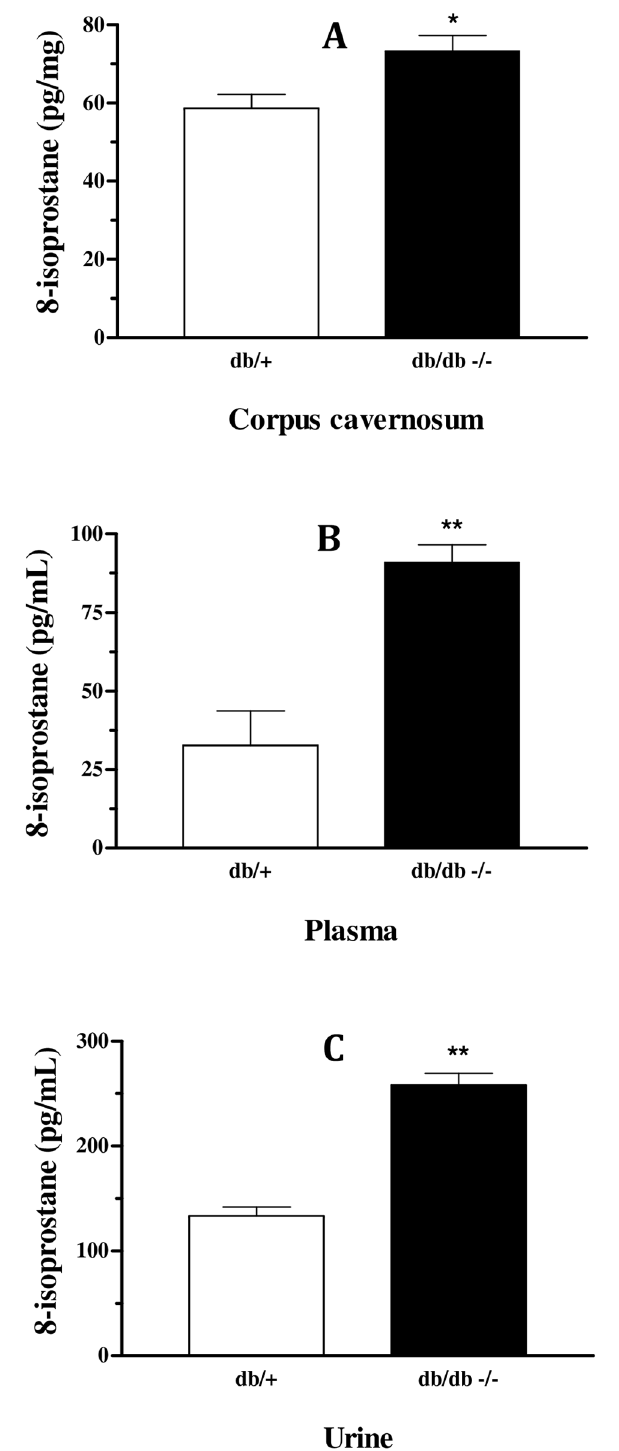
Fig 5. Increased lipid peroxidation, measured by formation of 8-isoprostane, in CC (Panel A), plasma (Panel B) and urine (Panel C) of db/db mice compared to db/+. Data represents the mean ± S.E.M. of 4 – 6 experiments * P < 0.05 and ** P < 0.01, compared to db/+